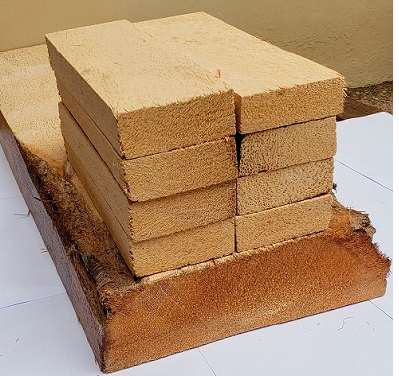
Figure 2. Specimens for observation in 18 weeks.